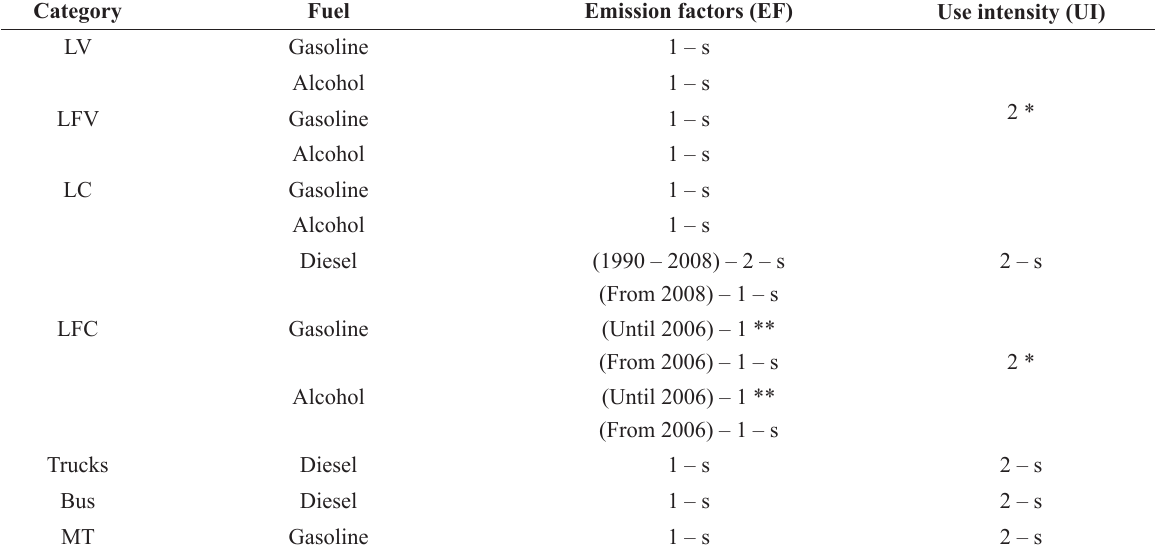
Information of the data provenance utilized of emission factors and use